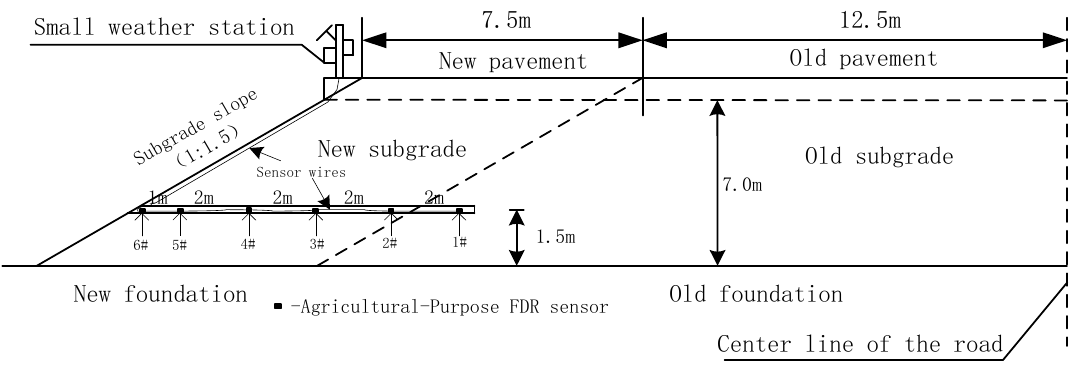
Figure 3. Embedding sketch for an agricultural-purpose FDR sensor.